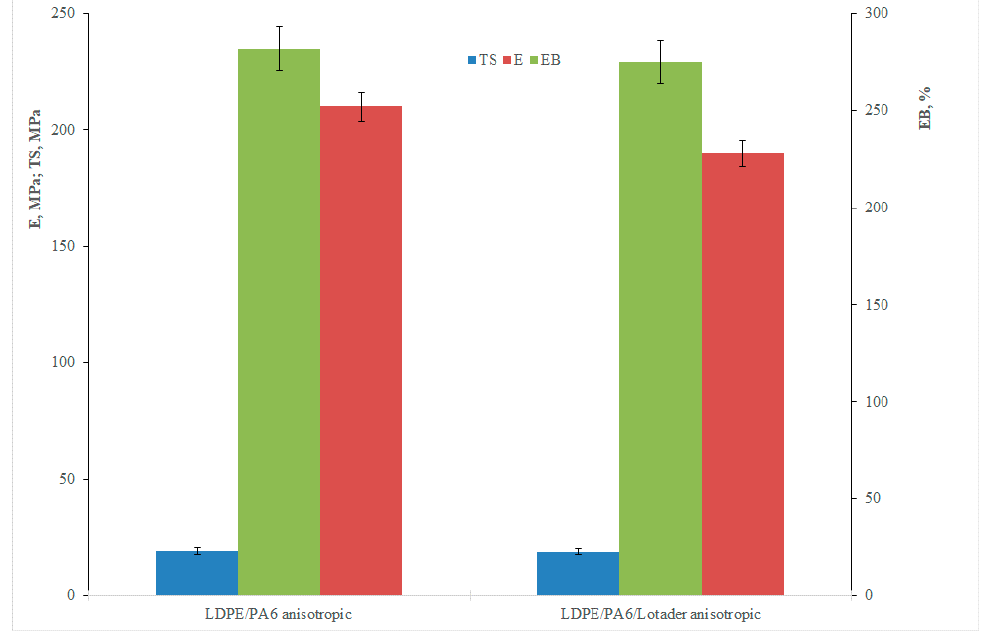
Figure 5. Tensile properties of the anisotropic blends.